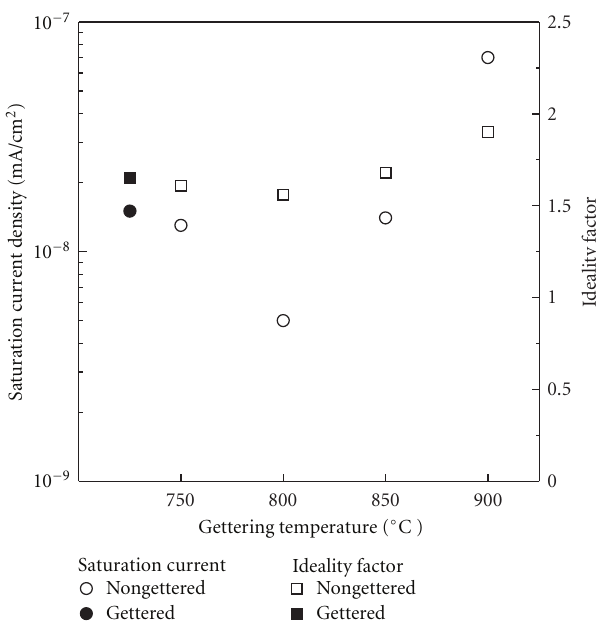
Figure 7: Calculated saturation current and ideality as a function of gettering temperature.